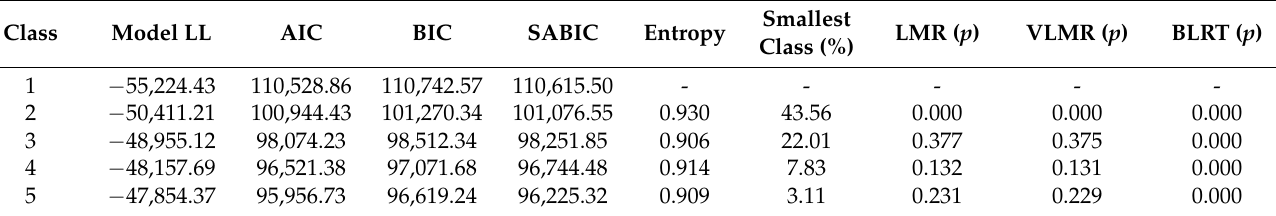
Table 1. Determination of class number for Group 1–20 items.